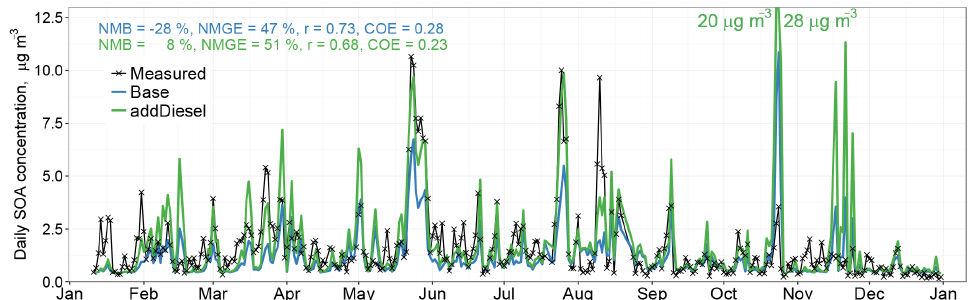
Figure 16. Time series of measured and modelled daily average SOA concentrations at the London North Kensington urban background site. The two outliers (23 and 24 October, included in the plot as labels) are excluded from the model evaluation statistics presented in the plot.